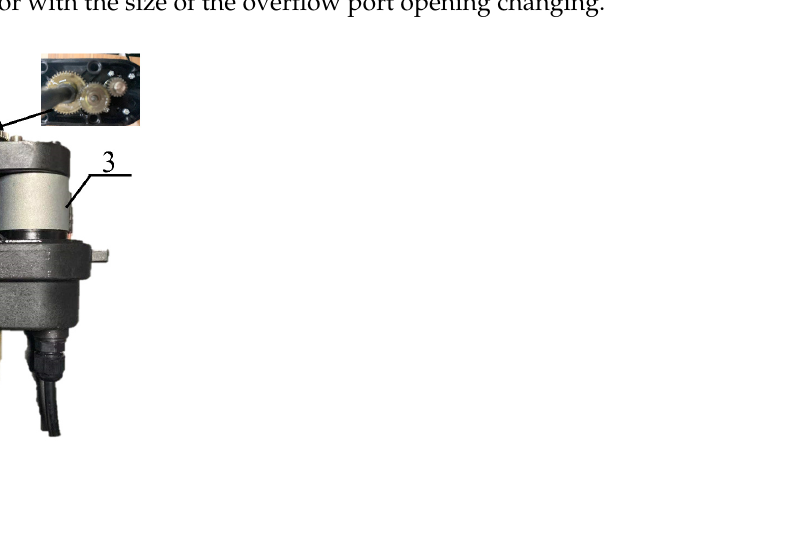
Figure 1. Structure of flow control valve: 1, gear train; 2, screw; 3, DC motor; 4, spool valve.